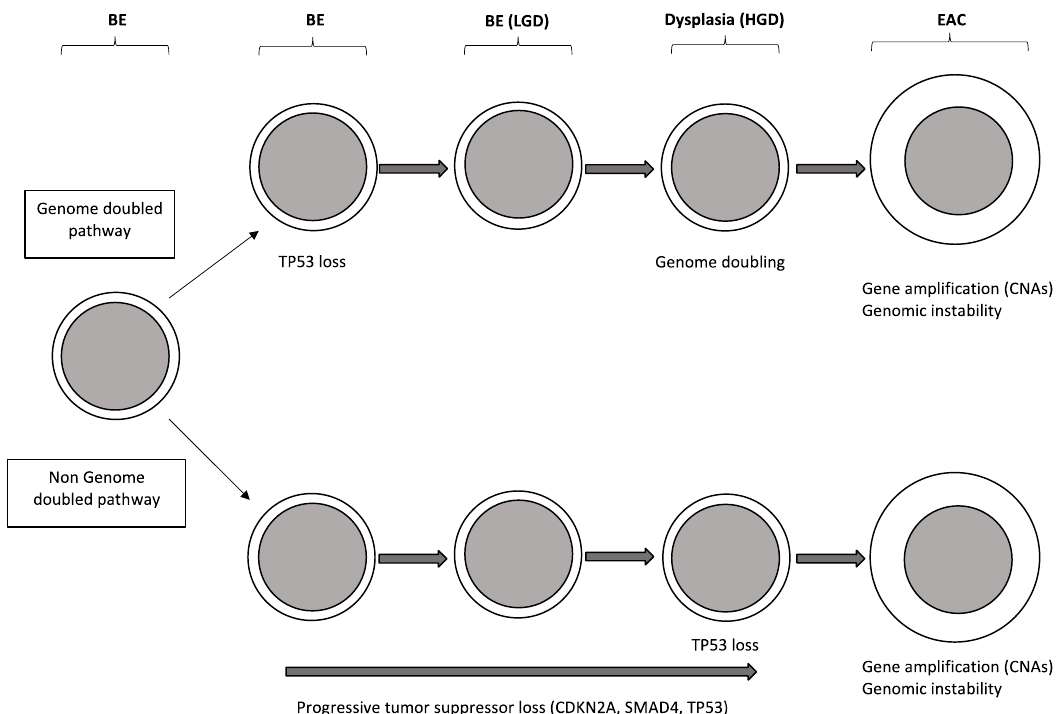
Figure 3. Schematic representation of two possible pathways of BE progression to EAC. The top model shows the tumor progression pathway involving genome doubling: this pathway implies the early occurrence of TP53; the genome doubling leads to genomic instability, oncogene amplification with frequent copy number alterations and aneuploidy. The bottom model shows the BE progression to EAC involving the gradual and progressive accumulation of tumor suppressor losses, followed by activation of oncogenes and development of genomic instability. Abbreviations: CAN: copy number alteration; BE: Barrett’s esophagus; LGD: low ‐ grade dysplasia; HGD: high ‐ grade dysplasia. This model is based on data reported by Stachler et al. [23].